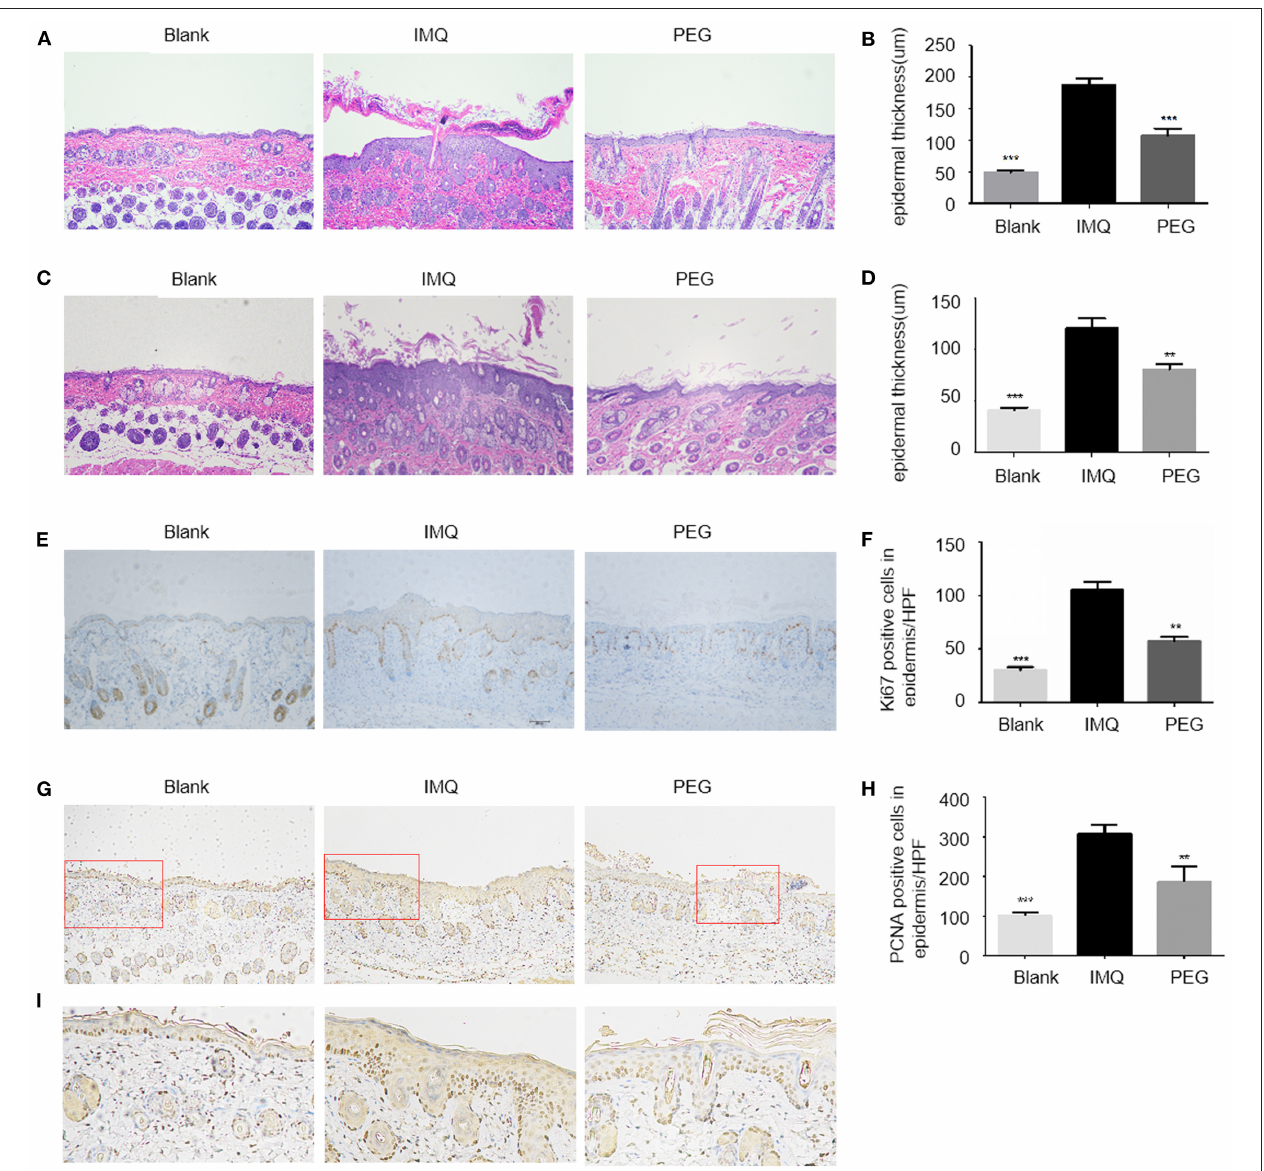
The mouse spleen was isolated and ground, and the red blood cells were lysed with 1 × lysing buffer (BD, USA). Then, the spleen cells were resuspended with 1 × PBS buffer for staining.